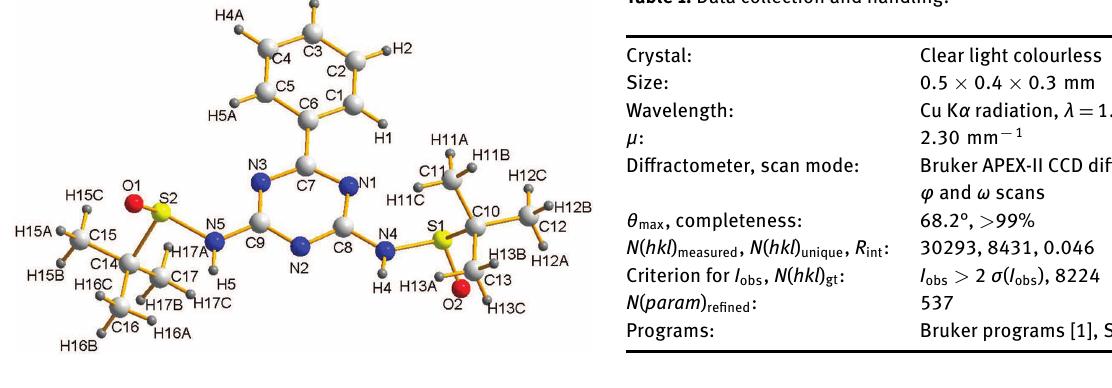
Table 1: Data collection and handling.